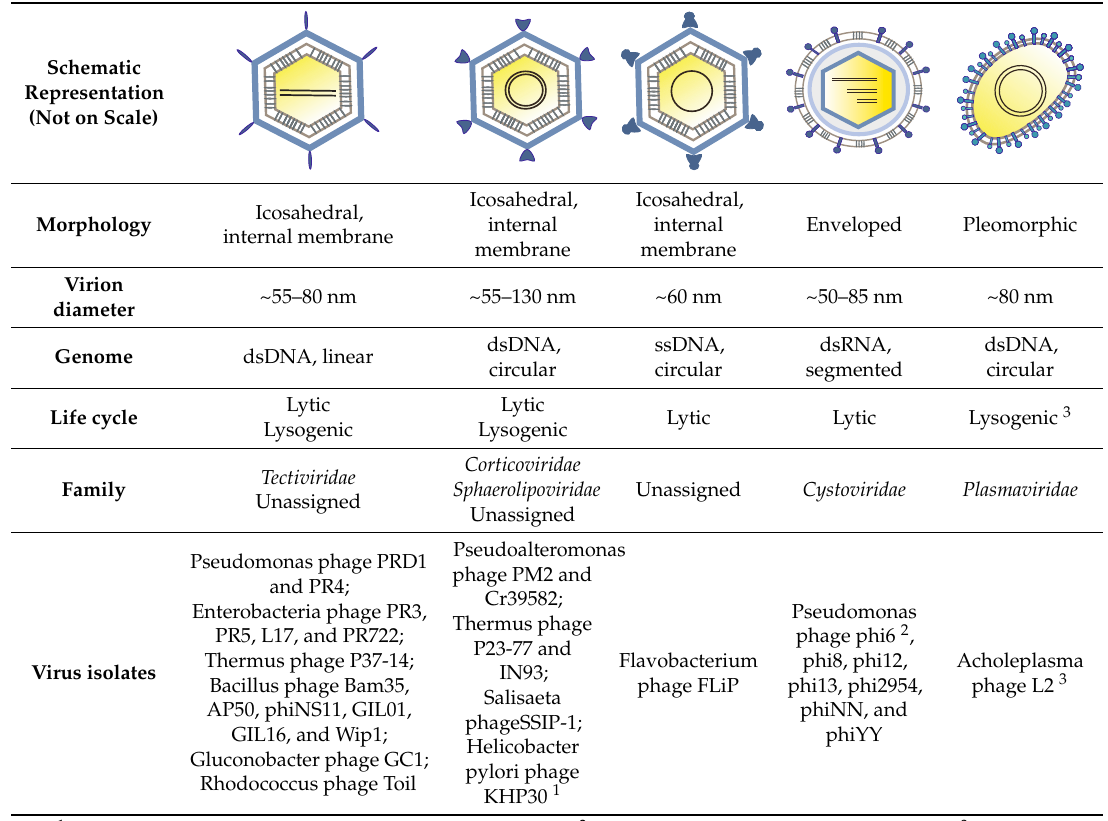
Table 1. Virus isolates of the membrane-containing bacteriophages with a complete genome sequence.